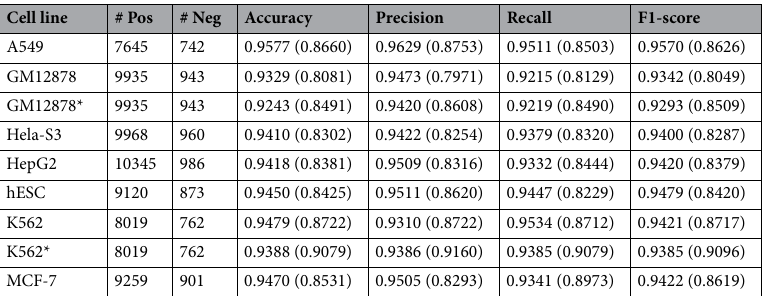
Two and seven activation markers. In the D-miRT model, DNase-seq and H3K4me3 are the only epigenetic markers used as input to the first CNN component (Fig. 1B). Along with them, five other histone markers; H3K27ac, H3K27me3, H3K36me3, H3K4me1 and H3K9me3 are used in the model variations with seven marker features. The H3K4me3, H3K27ac, H3K4me1, H3K9me3 and H3K27me3 signals are also associated with TSSs, in which H3K27ac is an active marker, H3K4me3 and H3K4me1 can be active or poised markers, and H3K9me3 and H3K27me3 are markers for transcription repression. H3K36me3 is an active marker of gene transcription at gene bodies. The five histone marks are appended to the original DNase-seq and H3K4me3 markers to create a 50 × 7 input matrix as an input to the second CNN component. With or without a score threshold. The D-miRT model outputs an 11 × 1 vector containing the probability dis- tribution for the 11 types of samples. The score threshold corresponds to the minimum prediction probability in the output vector required for a region to be claimed as negative or accepted as positive with the TSS in the corresponding bins. D-miRT uses the threshold 0.8, which means, out of the 11 output, the type with at least 0.8 probability gets the value 1, while others get the value 0. If there is no type with at least 0.8 probability, the input region is not predicted. In case of the model variations without the score threshold, only the type with the high- est probability was assigned the value 1.